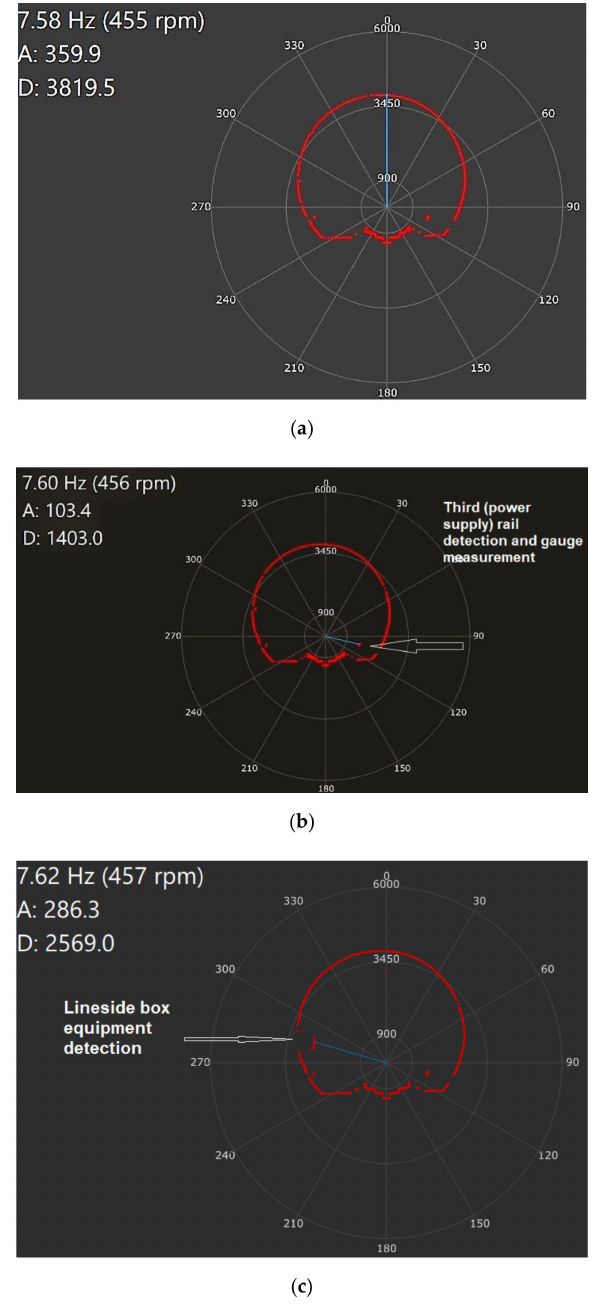
Figure 9. Gauge measurement with LIDAR, ( a ) tunnel gauge profiling, ( b ) third rail (used in subway for power supplying), ( c ) lineside box equipment (LDE) gauge measurement (LDE is mounted on the tunnel wall, round-shaped subway tunnel profile between